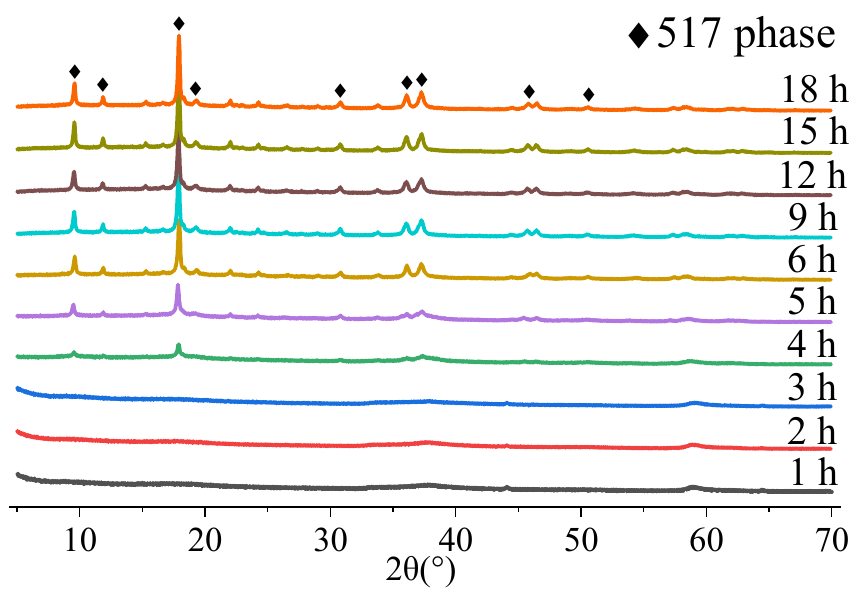
Figure 6. Tracking XRD patterns of samples with the addition of 0.8 wt% of